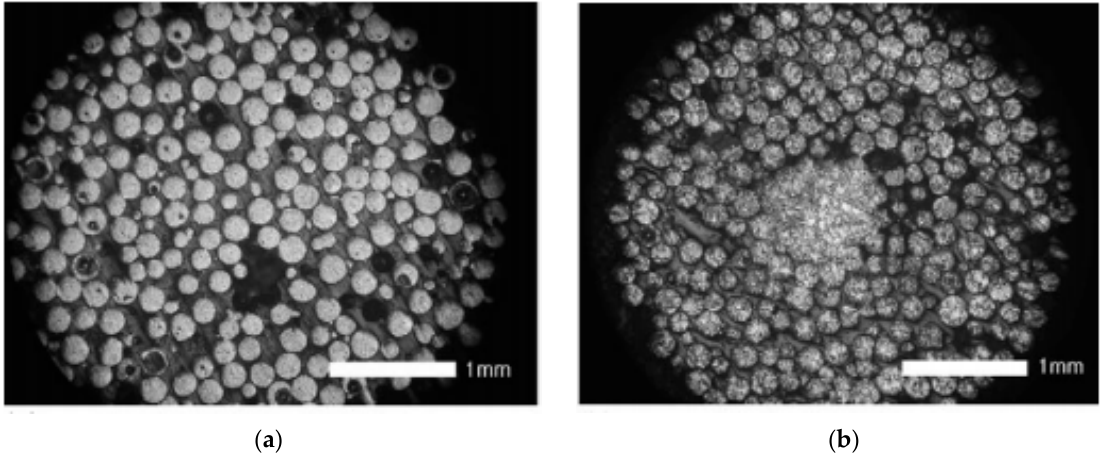
Figure 1. Effect of the pinch pressure under a low external applied pressure (7.8 MPa) on Ti powders: ( a ) powders joint at contact points with 1.07 kJ/g; ( b ) formation of a dense core with 1.43 kJ/g. Reprinted with permission from ref. [41], Copyright 2006 Elsevier.